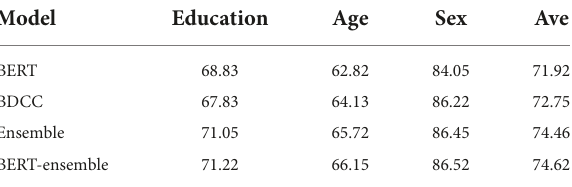
TABLE 6 Classification prediction results of different